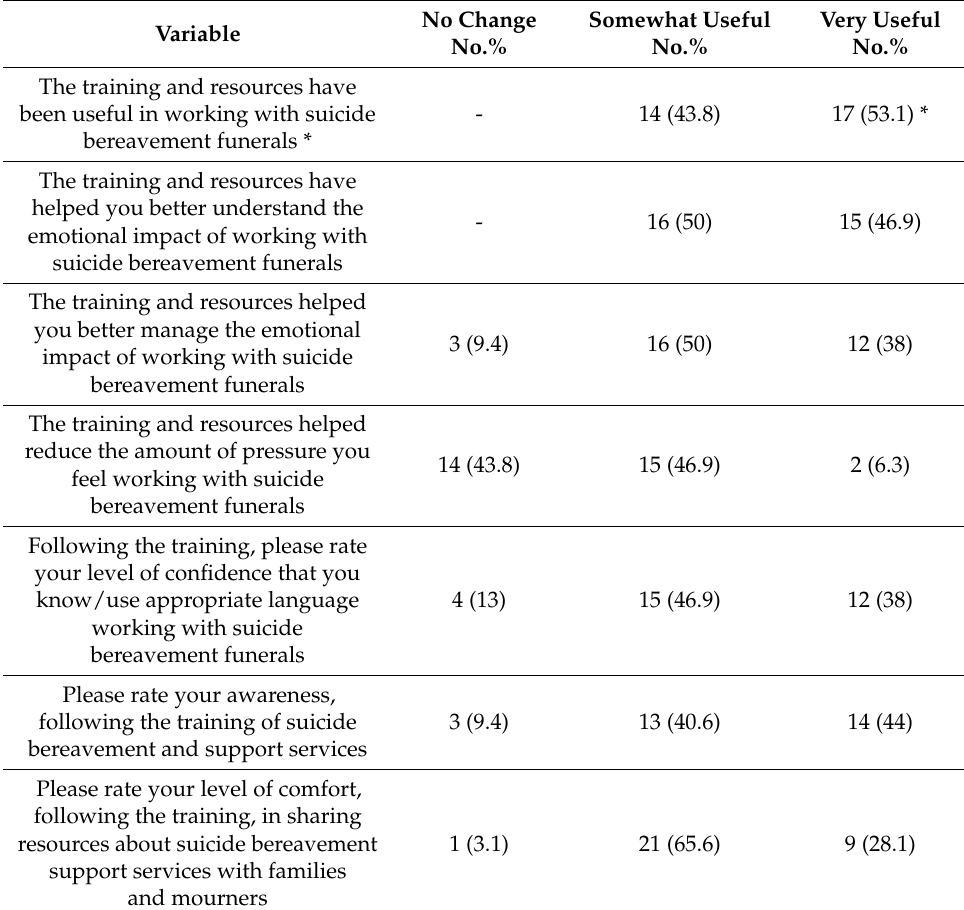
Table 2. Post-Training Questionnaire results ( n =